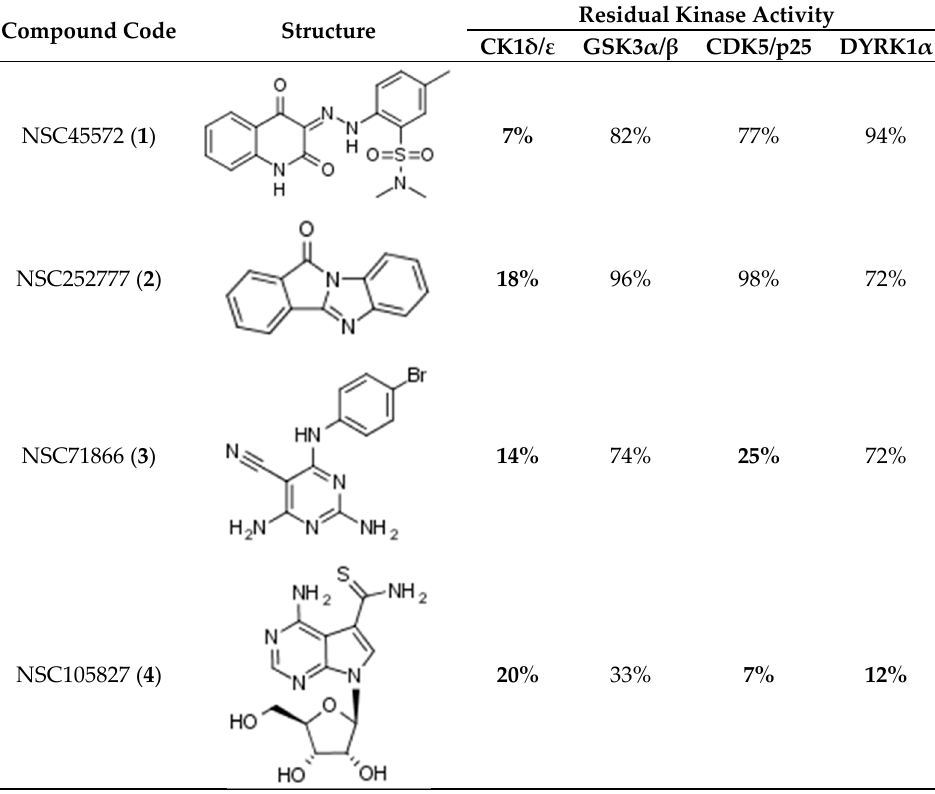
Table 1. The structures of the four NCI Diversity Set-II compounds affording the best results in the kinase inhibition assay towards CK1 δ / ε , along with their residual enzyme activities at 10 μ M and their selectivity against three related protein